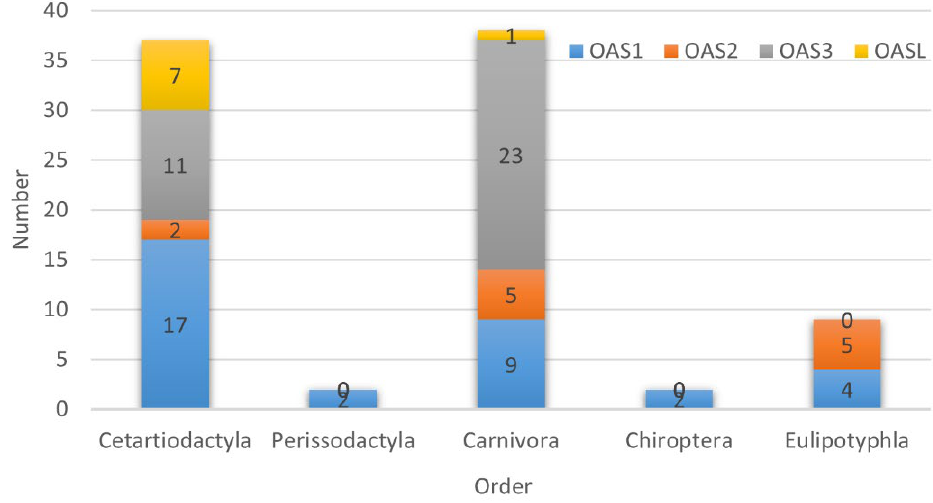
Figure 3. Analysis of positive selection sites for Laurasiatherian mammal species. Table 2. Positive selection sites obtained from the FUBAR model.